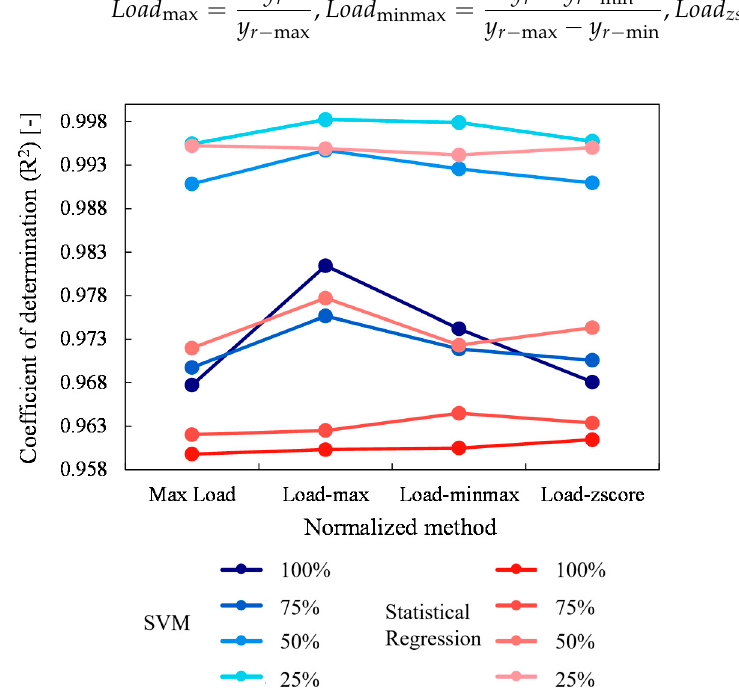
Figure 12. Comparison of prediction accuracy for support vector machine (SVM) and statistical regression data based on data normalization (R 2 ). Table 5. Prediction accuracy of Load-max for SVM and statistical regression data with the number of data.